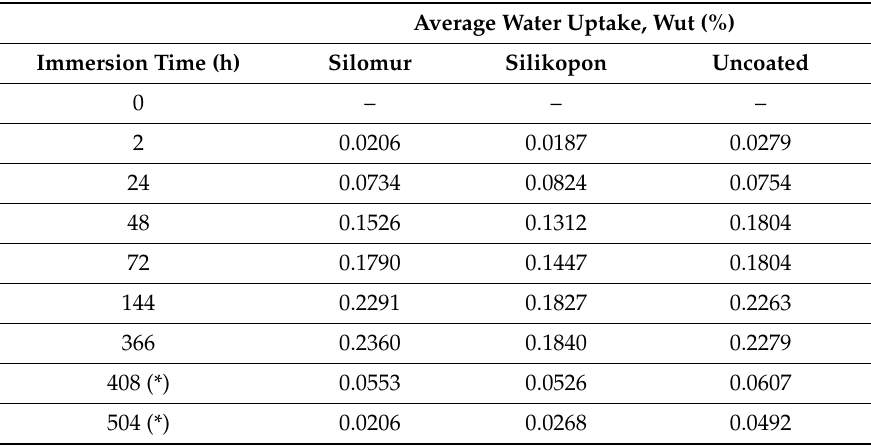
Table 2. Test conditions and average water uptake